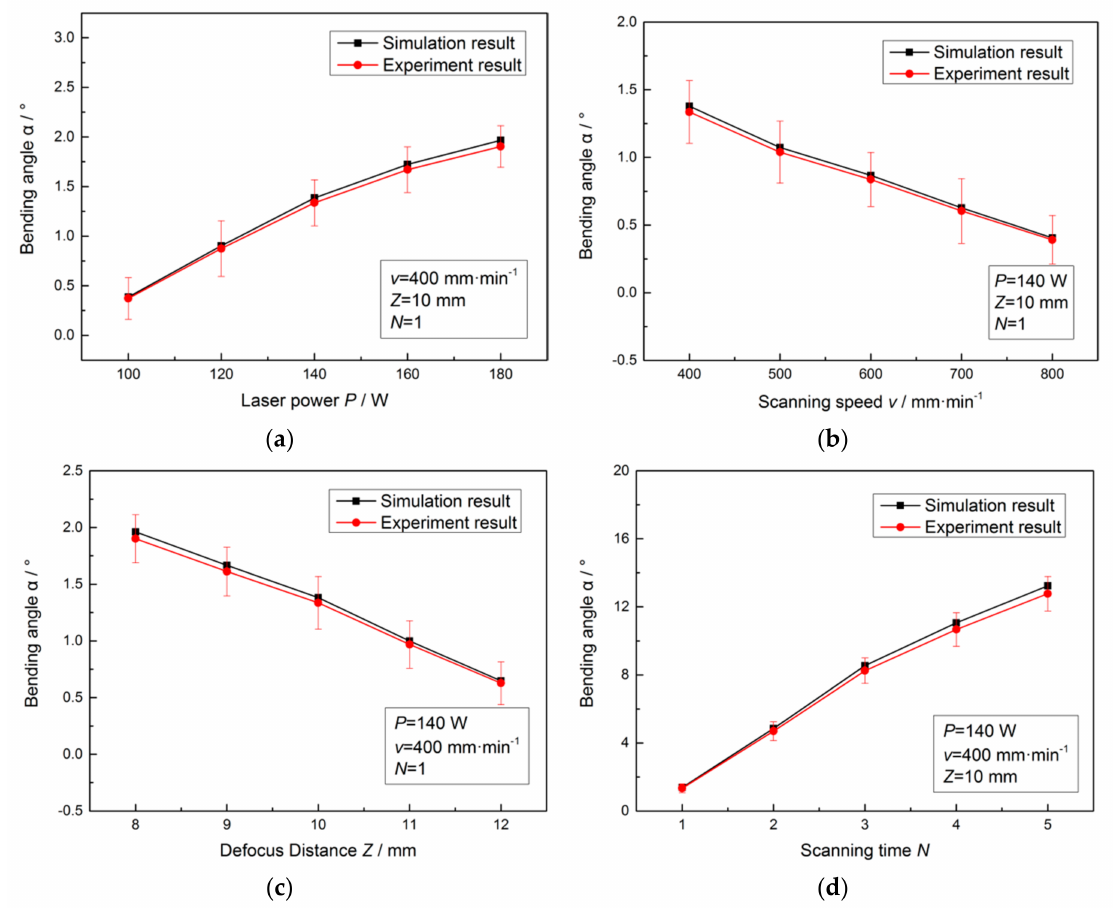
Figure 7. Comparison between the simulation results and the experimental verification: ( a ) Bending angle under laser power; ( b ) Bending angle under scanning speed; ( c ) Bending angle under defocus distance; ( d ) Bending angle under scanning